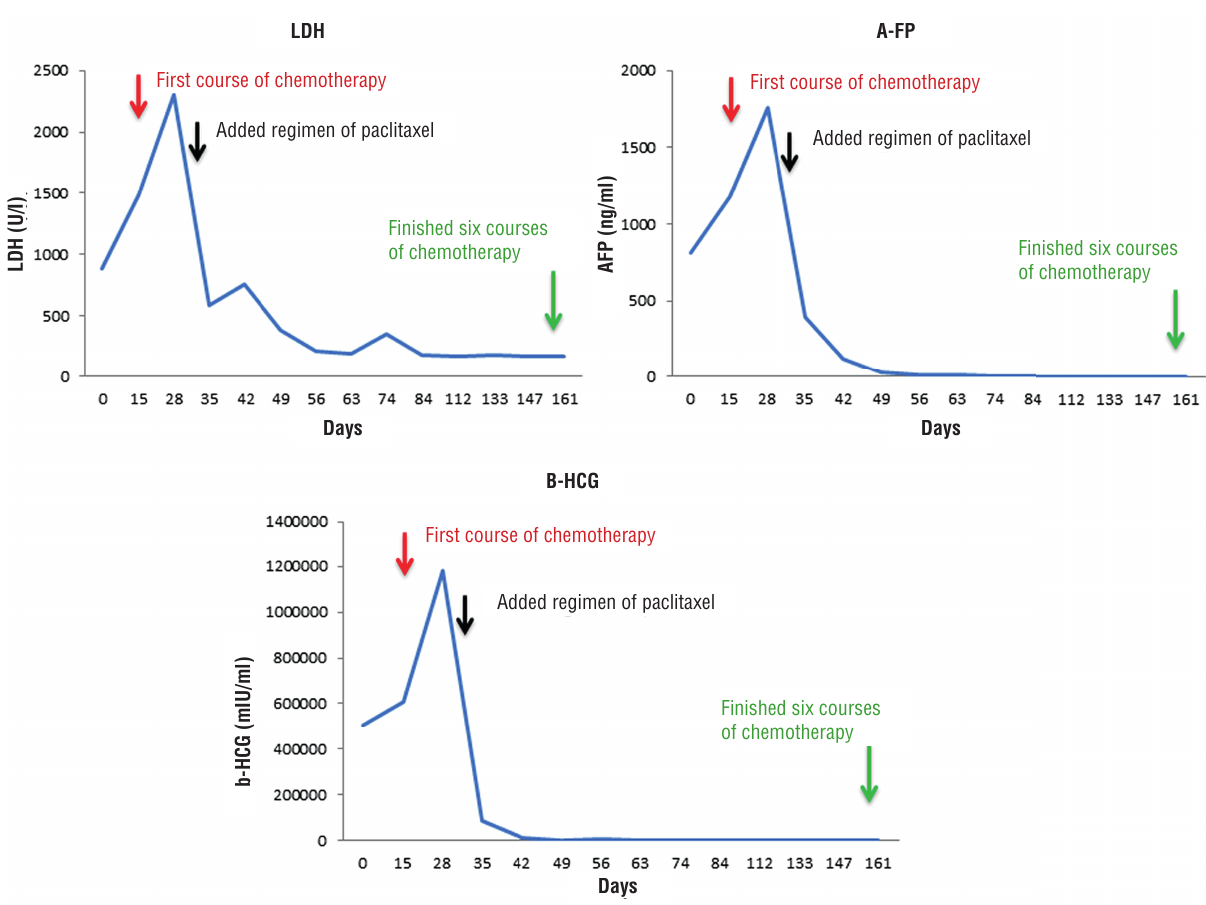
Figure 2 - The tumor marker changes from the initial diagnosis to the end of six courses of